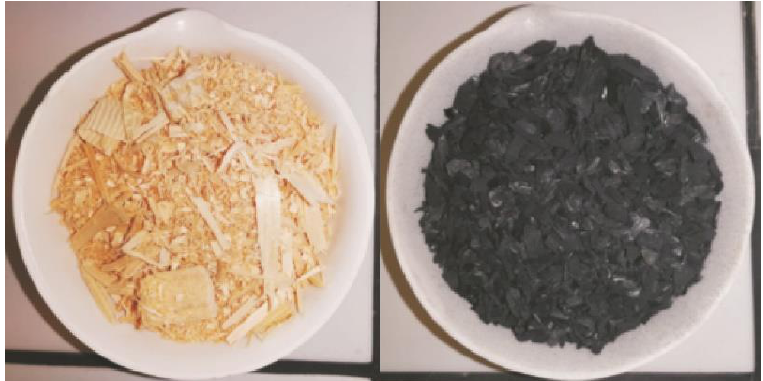
Figure A5. The left side of the photo shows conifer wood residues. The right side shows the biochar obtained by the conifer biomass after industrial thermochemical carbonization (i.e., gasification). The conifer biochar showed here was analyzed in de Pasquale et al. [99]. The amount of ash resulted 80 ± 7 g kg −1 .